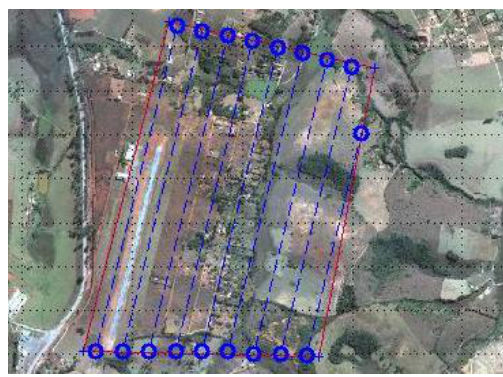
Figure 12. Coverage area used in the experiments overlaid on a satellite